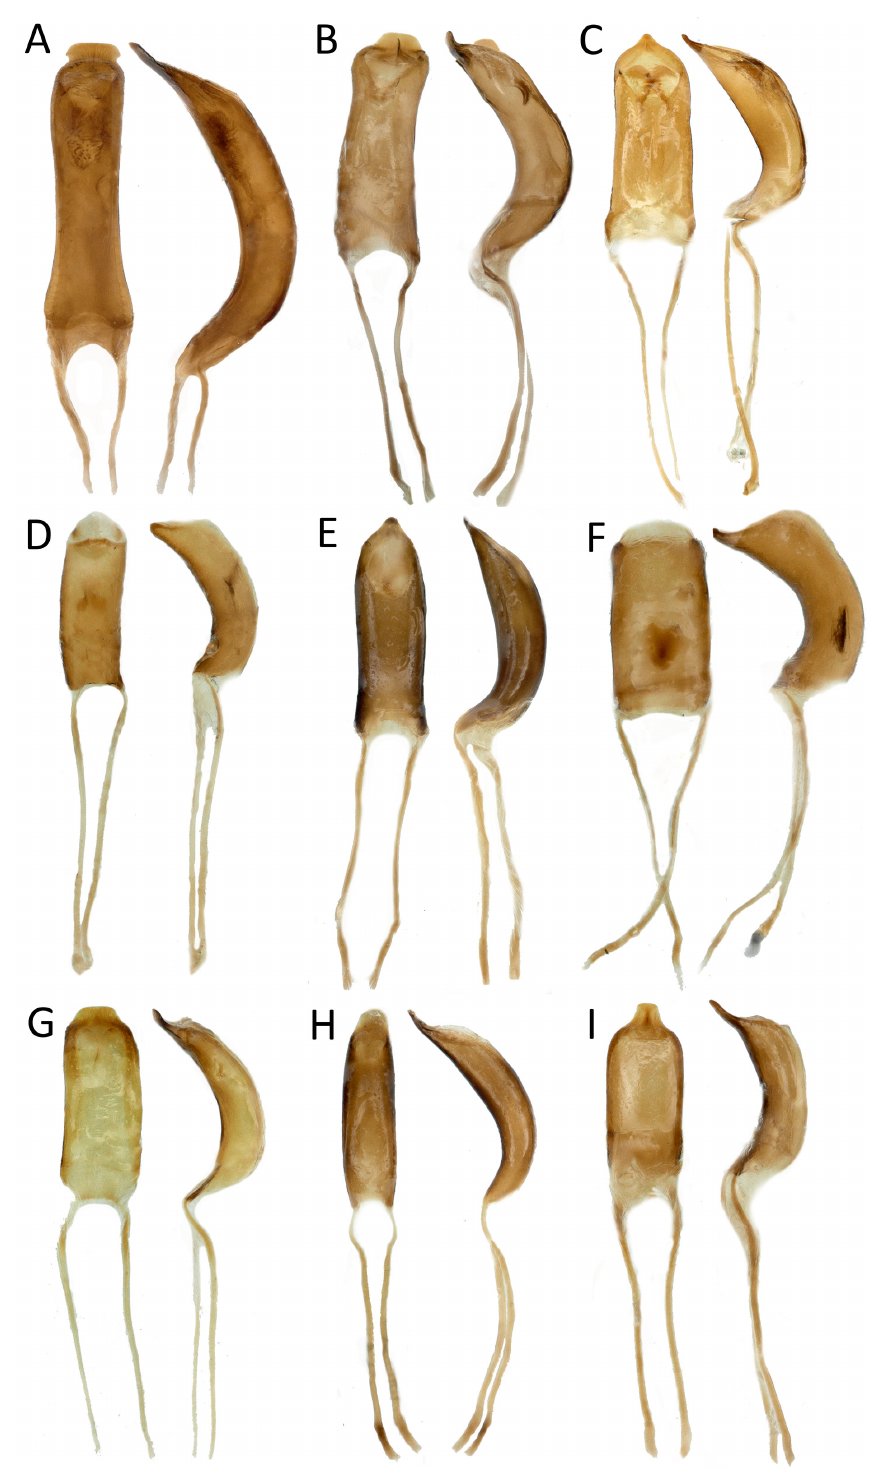
Fig. 6 (part 1). A–I . Male genitalia of Ebenacobius Haran gen. nov., penis in dorsal (left) and lateral (right) view. A . E. curvisetis Haran gen. et sp. nov. B . E. rectirostris Haran gen. et sp. nov. C . E . duplicatus Haran gen. et sp. nov. D . E. grobbelaarae Haran gen. et sp. nov. E . E . costalis (Fåhraeus, 1844) gen. et comb. nov. F . E . thoracicus Haran gen. et sp. nov. G . E. xhosa Haran gen. et sp. nov. H . E . san Haran gen. et sp. nov. I . E. kuscheli Haran gen. et sp. nov. A–I = not to